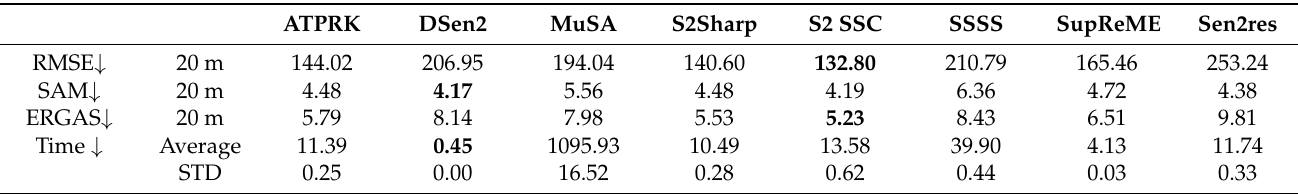
Table 1. Evaluation using reduced scale S2 data: Reduced by 2, super-resolved 40 → 20 m. The best results are given in bold typeface.